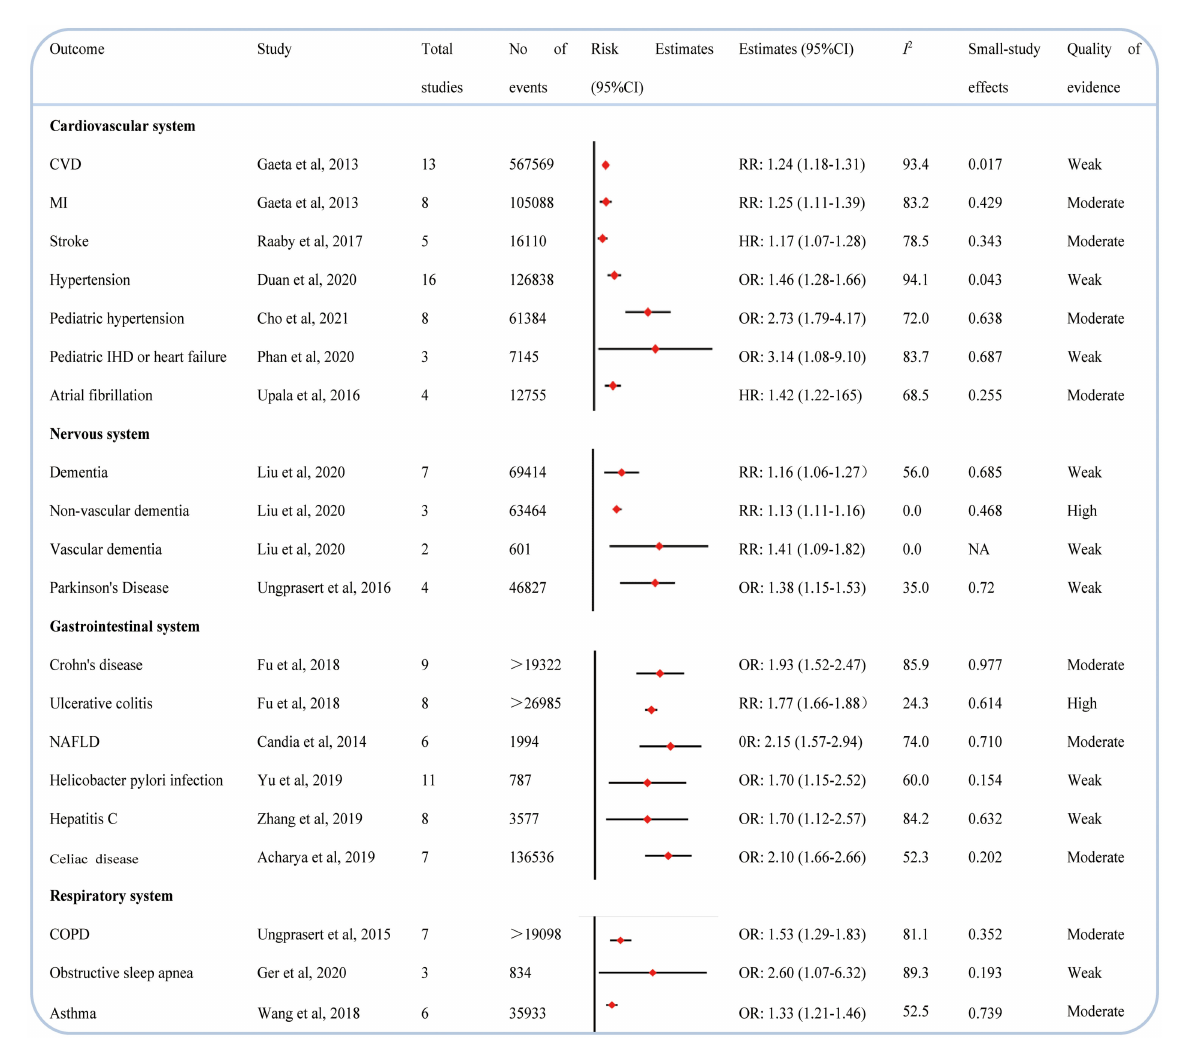
FIGURE5 Associations between psoriasis and cardiovascular diseases (CVDs), nervous system, gastrointestinal system disease, and respiratory system